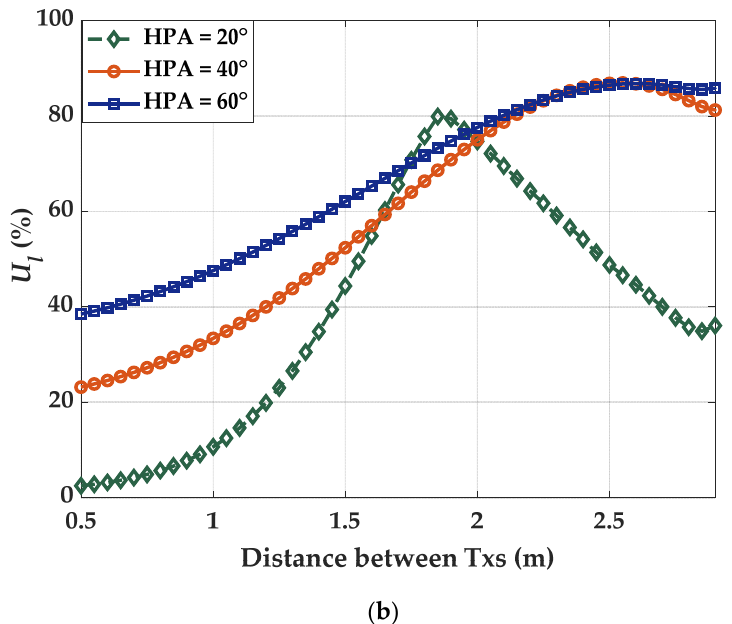
Figure 8. Comparison of uniformity for different HPA and distance between the Txs in case of ( a ) 4-Tx, and ( b ) 9-Tx.